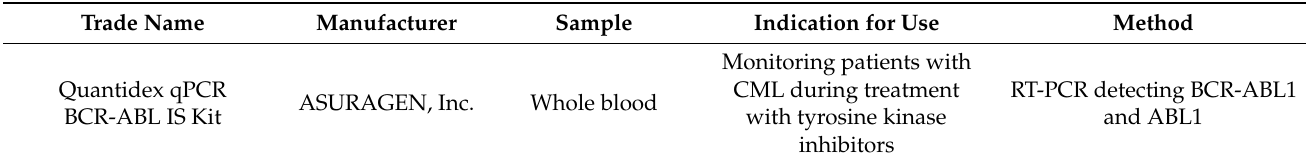
Table 5. FDA approved RNA-based tests for liquid-biopsy